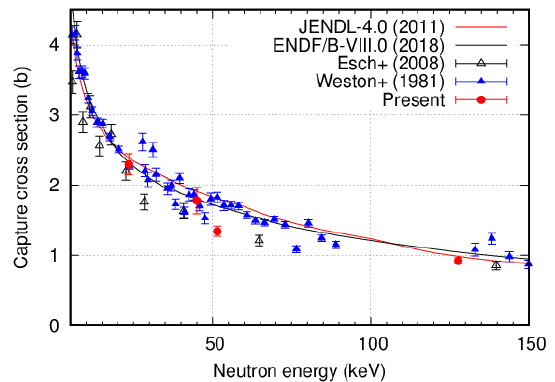
Fig. 6. Neutron capture cross section of 237 Np. The present experimental results are compared with past experimental data and evaluated cross sections.